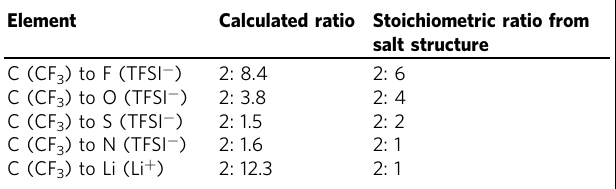
Table 2 Evaluation of the relative amounts of the different LiTFSI components in the Elect-Drop sample Element Calculated ratio Stoichiometric ratio from salt